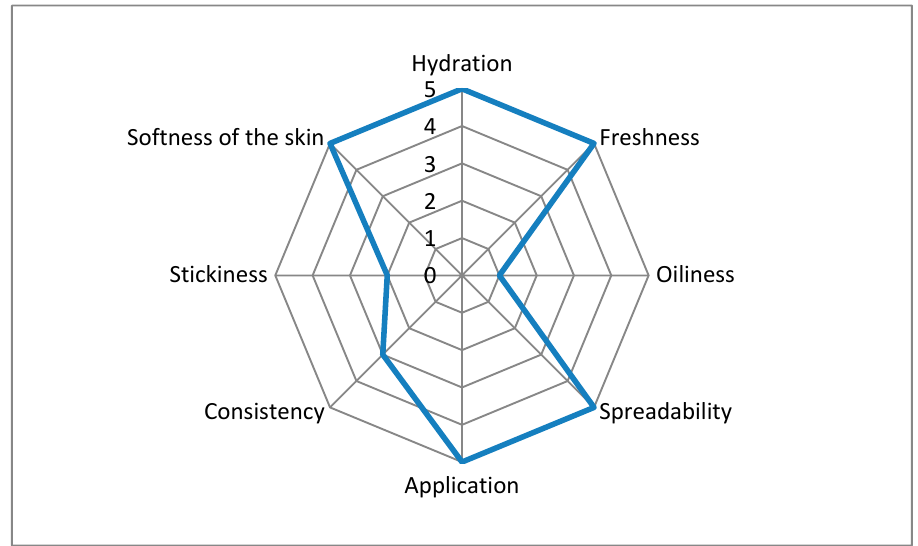
Figure 5. Results of sensory analysis of the emulsion with 2.0% of açai extract.